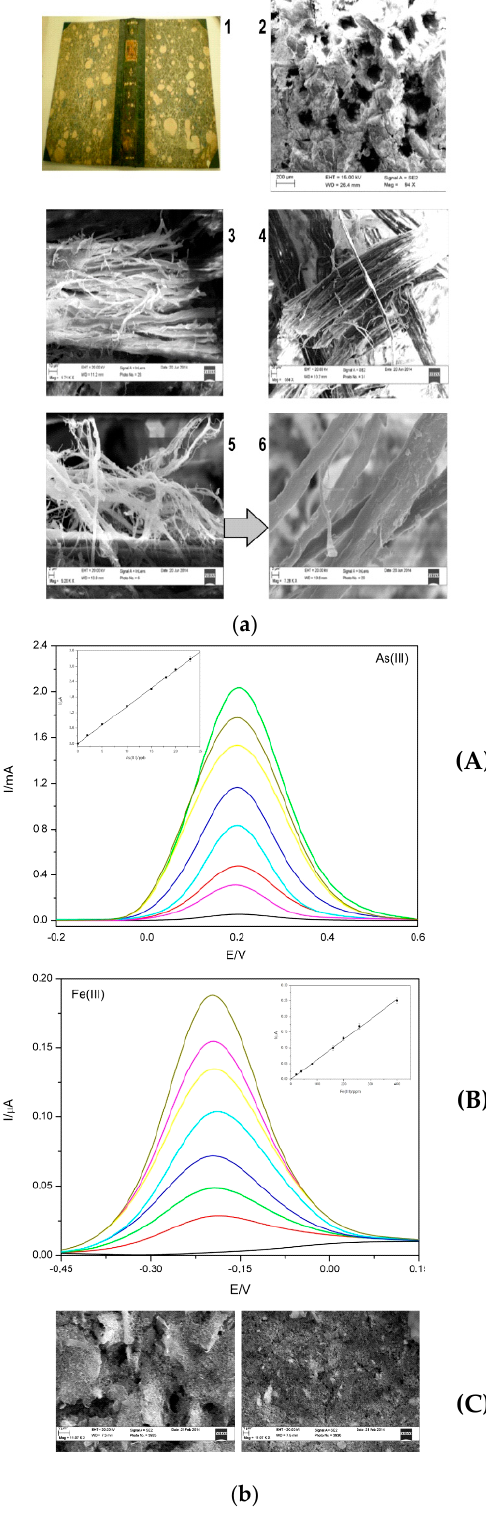
Figure 7. ( a ): 1 is the image of the original leather cover. From 2 to 6 : SEM of the leather samples (flower side and flesh side of the skin / leather samples). In ( b ): ( A ) represents the calibration for As(III), ( B) represents the calibration for Fe(III), ( C ) shows FE-SEM / EDAX micrographs, before (left image) and after (right image) GO modification of SPEs. Reproduced and reprinted with permission from